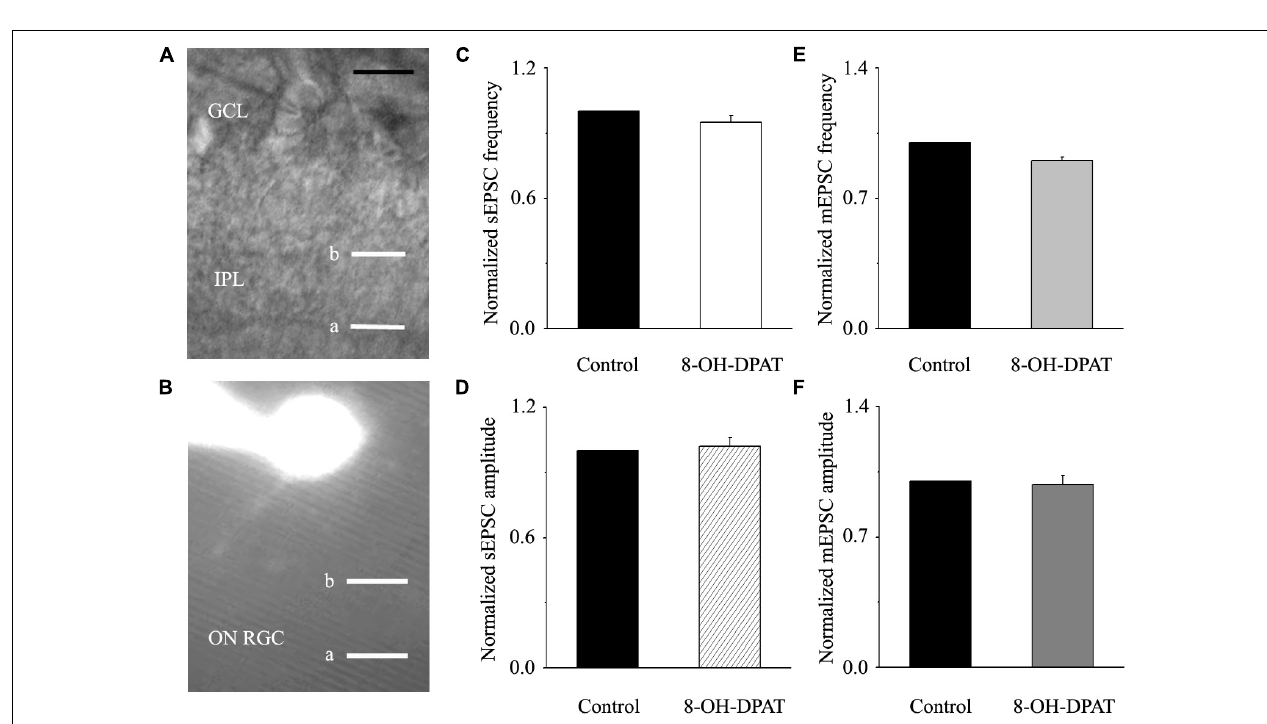
FIGURE 9 | 8-OH-DPAT did not change the frequency or amplitude of sEPSCs or mEPSCs in ON-type RGCs. (A,B) The micrograph in (A) was taken with an infrared interferometric phase microscope, and the retinal layers can be seen. Representative Lucifer yellow-filled ON-type RGCs with dendritic arborizations in the distal (b) parts of the IPL are shown. (C,D) Normalized sEPSC frequency and amplitude ( n = 7). (E,F) Normalized mEPSC frequency and amplitude ( n = 10). GCL, ganglion cell layer; IPL, inner plexiform layer. Scale bar: 10 µ m. a, the dendritic arborizations in the proximal (a) parts of the IPL.